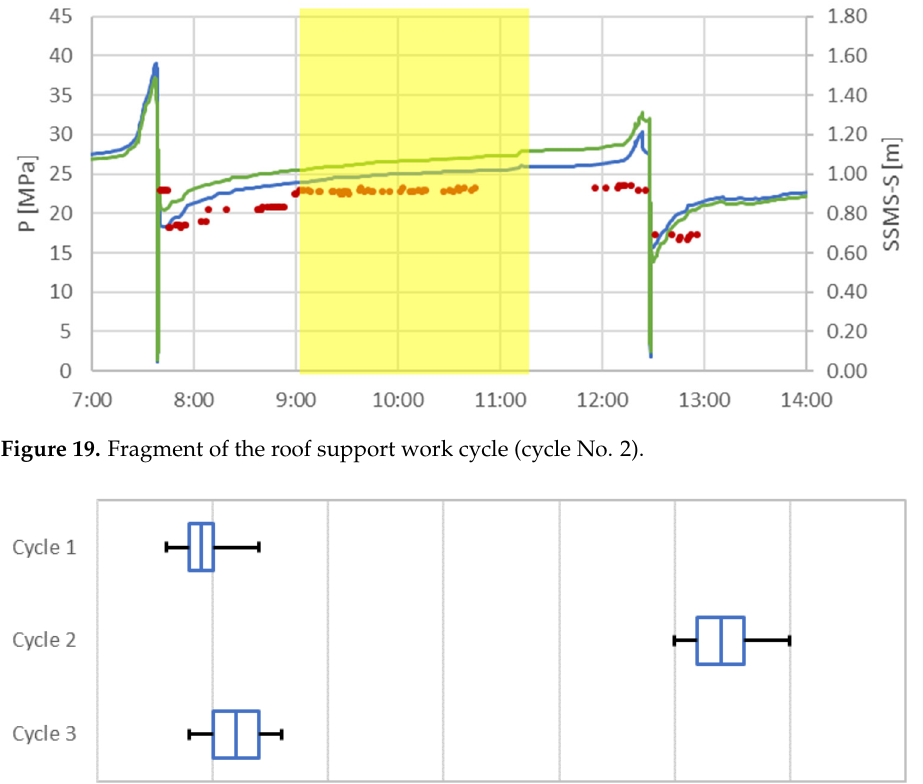
Figure 20. Box-and-whisker plot (scatter and shape of analysed data): tip-to face distance, cycle No. 1, 2 and 3. Table 2. Summary of the calculations used to present a box-and-whisker diagram for the tip-to face distance.